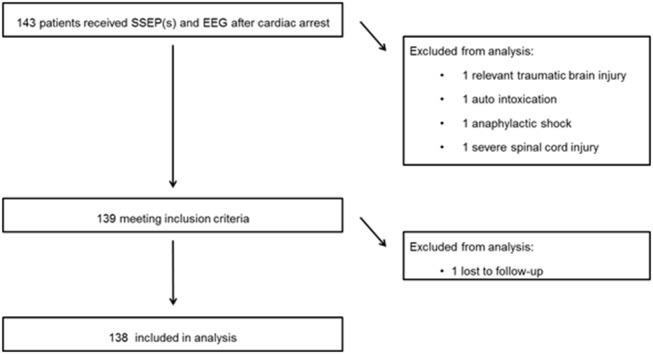
Flow of patients through this study. SSEP, somatosensory evoked potential; EEG, electroencephalogram.